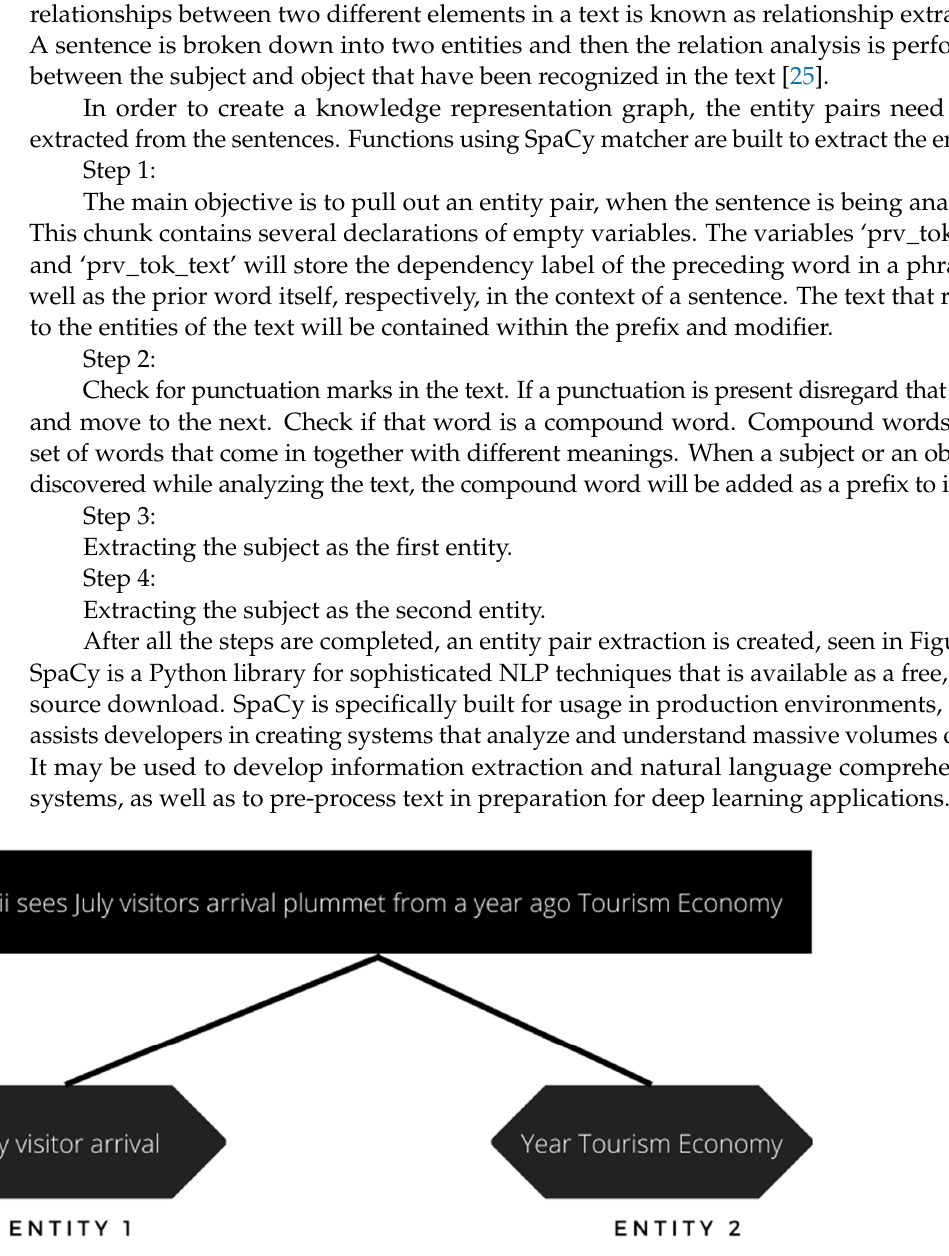
Figure 12. Pattern Added to the Matcher.